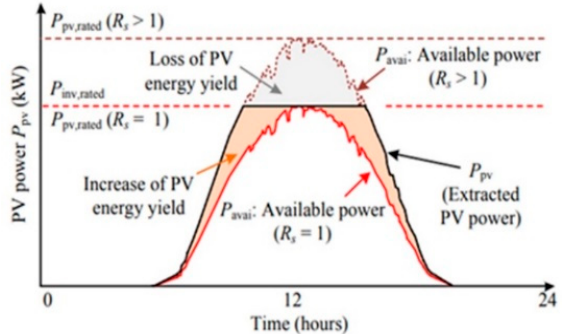
Figure 29. Extraction of Power generation with oversized PV arrays.